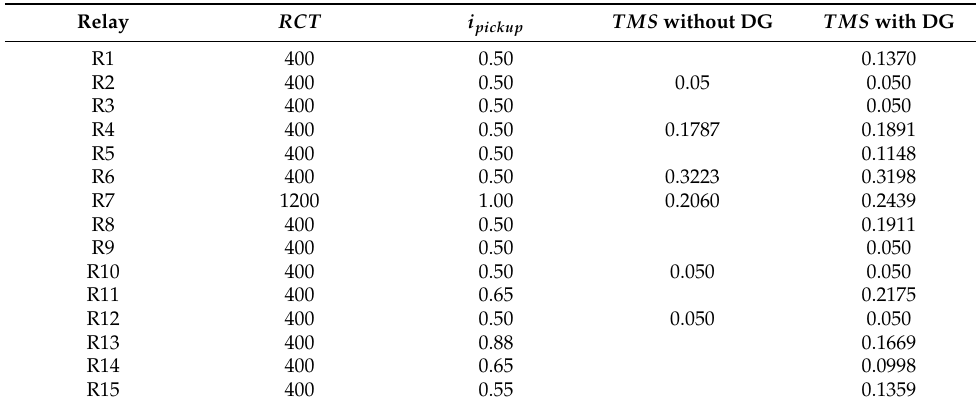
Figure 5. Benchmark IEC microgrid with EVs. Table 4. RCT and i pickup for each